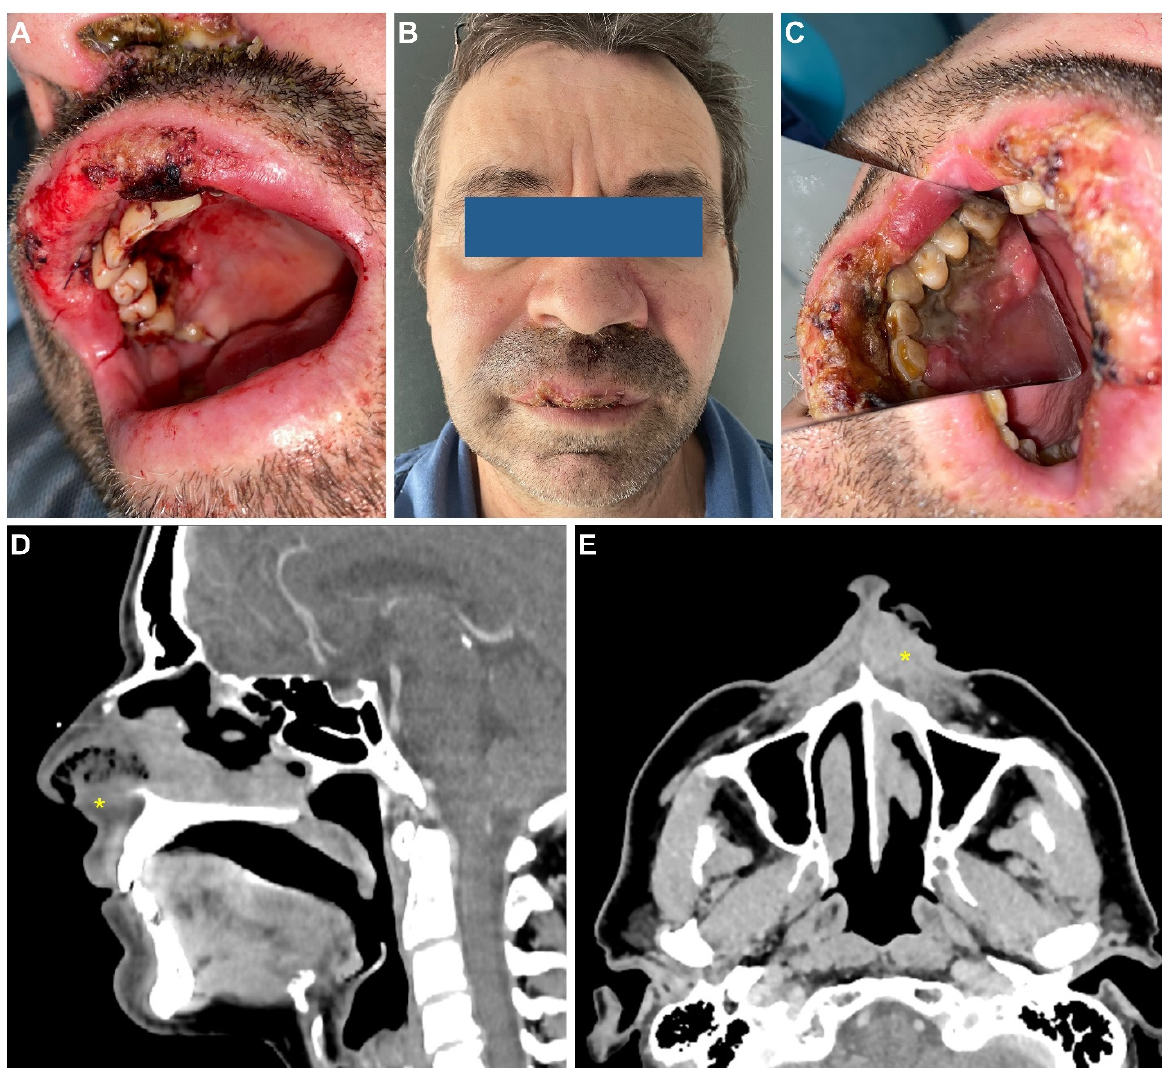
Figure 3. Clinical and imaging aspects at presentation. Intraoral aspect at the presentation to the emergency room, after superior labial artery ligature ( A ); clinical appearance after 2 days ( B , C ); contrast-enhanced CT scan of the neck in the sagittal ( D ) and axial ( E ) planes. Heterogeneous infiltrative mass (*) of the upper lip, left inferior nasal vestibule, and left inferior turbinate.